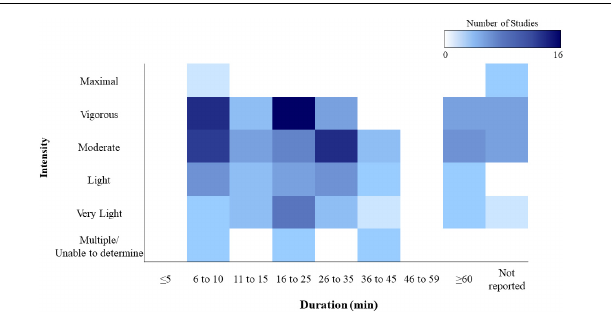
FIGURE 1 | Heat map illustrating the number of studies assessing changes across all cognitive domains by each intensity and duration. Studies using exercise intensities spanning multiple intensity categories (i.e., moderate-vigorous, moderate-varied) are included as “multiple/unable to determine.” Exercise duration excludes warm-up time. 73 total studies represented. Table inspired by Pontifex et al.